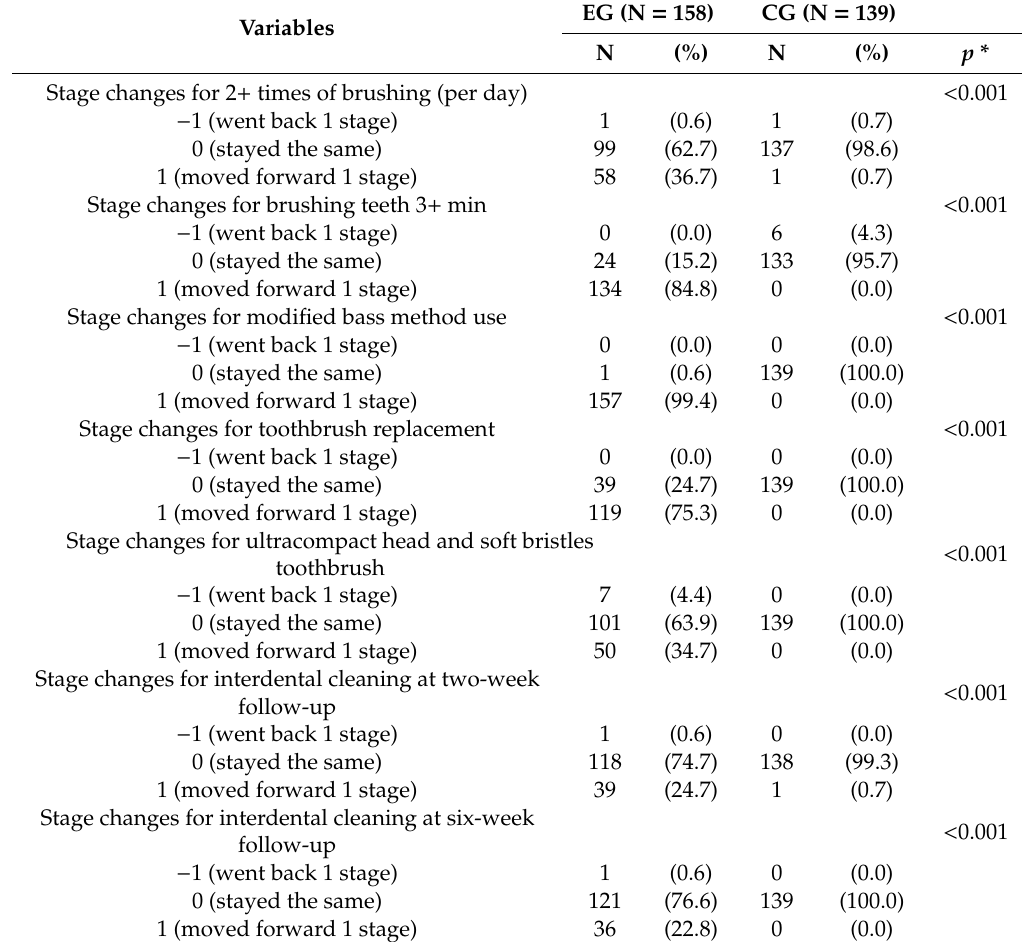
Table 3. Comparison of changes in oral self-care behaviors at di ff erent stages (baseline, two-week follow-up, and six-week follow-up) by